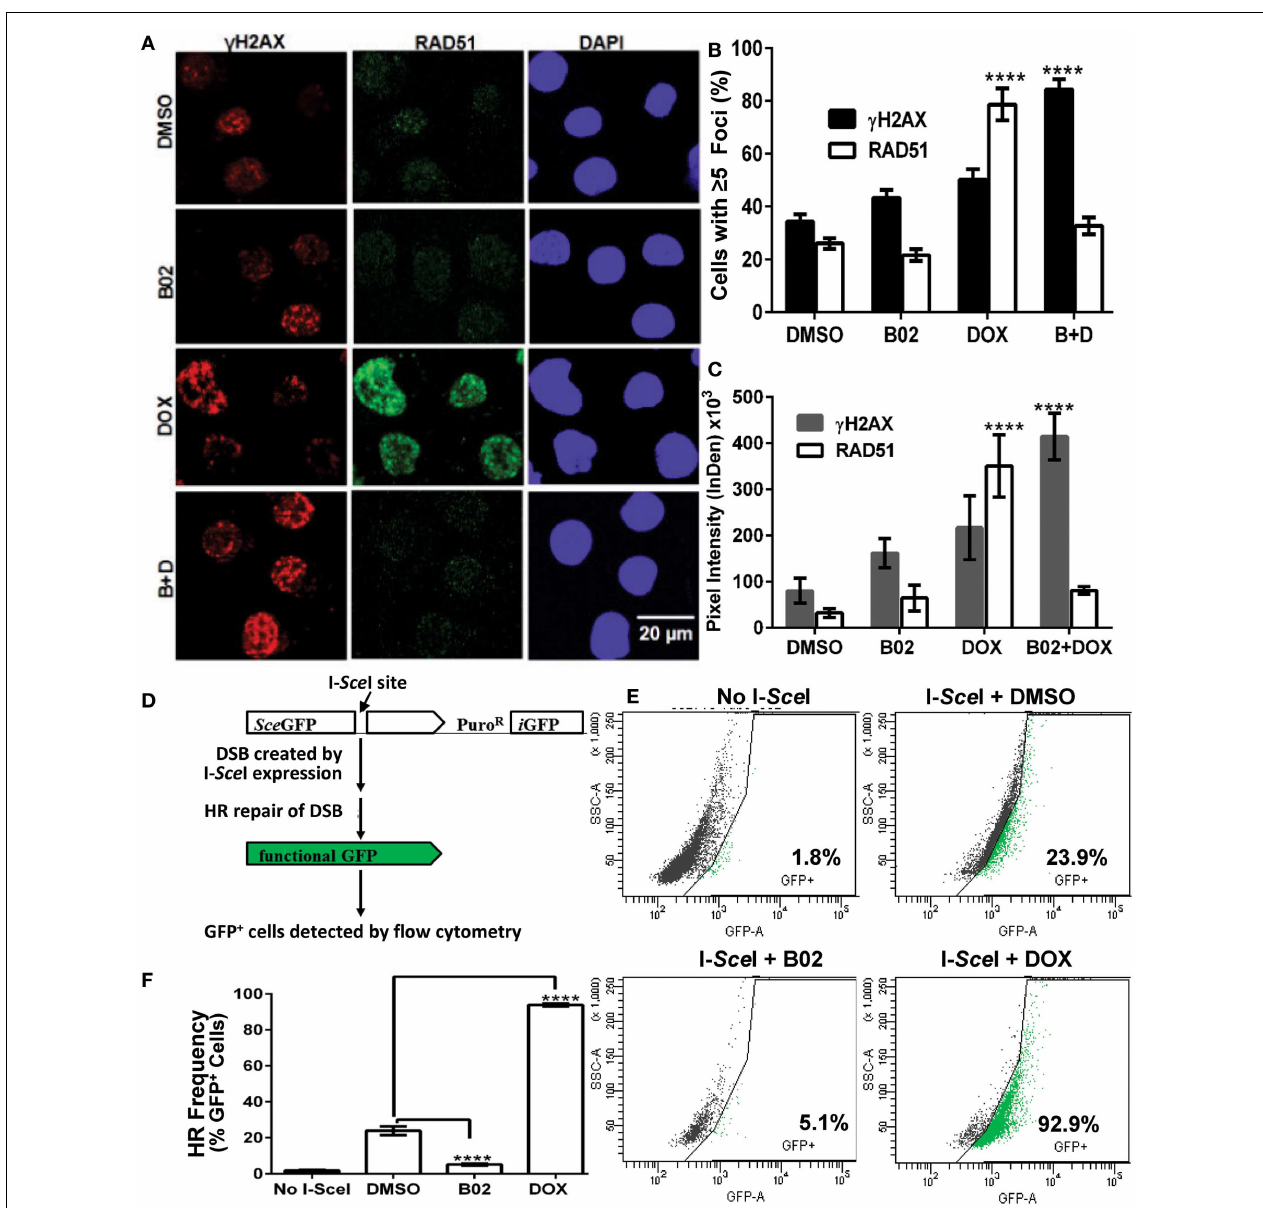
of the DR-GFP reporter, via cleavage at a unique I- Sce I site by site-specific endonuclease introduced by adenovirus infection. HR repair of these DSBs creates intact GFP genes, detected by flow cytometry. (E) Examples of flow-cytometric analysis of MM.1S-DR-GFP cells, wherein GFP fluorescence ( x axis signal) beyond the control boundary (segmented line) indicates HR repair. Background signal (1.8% of cells), defined in cells without I- Sce I introduction, rose to ~24% after I- Sce I expression. Lower panels show results for I- Sce I-exposed cells + B02 (~5% GFP + ) or + DOX (~93% GFP + ). (F) Summary of combined data from runs such as those illustrated in (E) , for cells without I- Sce I infection (mock), cells treated with vehicle (DMSO), 20- µ M B02, or 160-nM DOX for 24h after transient infection with I- Sce I expression adenovirus (AdNUGS24i). HR data combined from three experiments are presented as means ± SEM. Statistical significance between groups (each n = 3) by two-tailed t -tests: **** p <